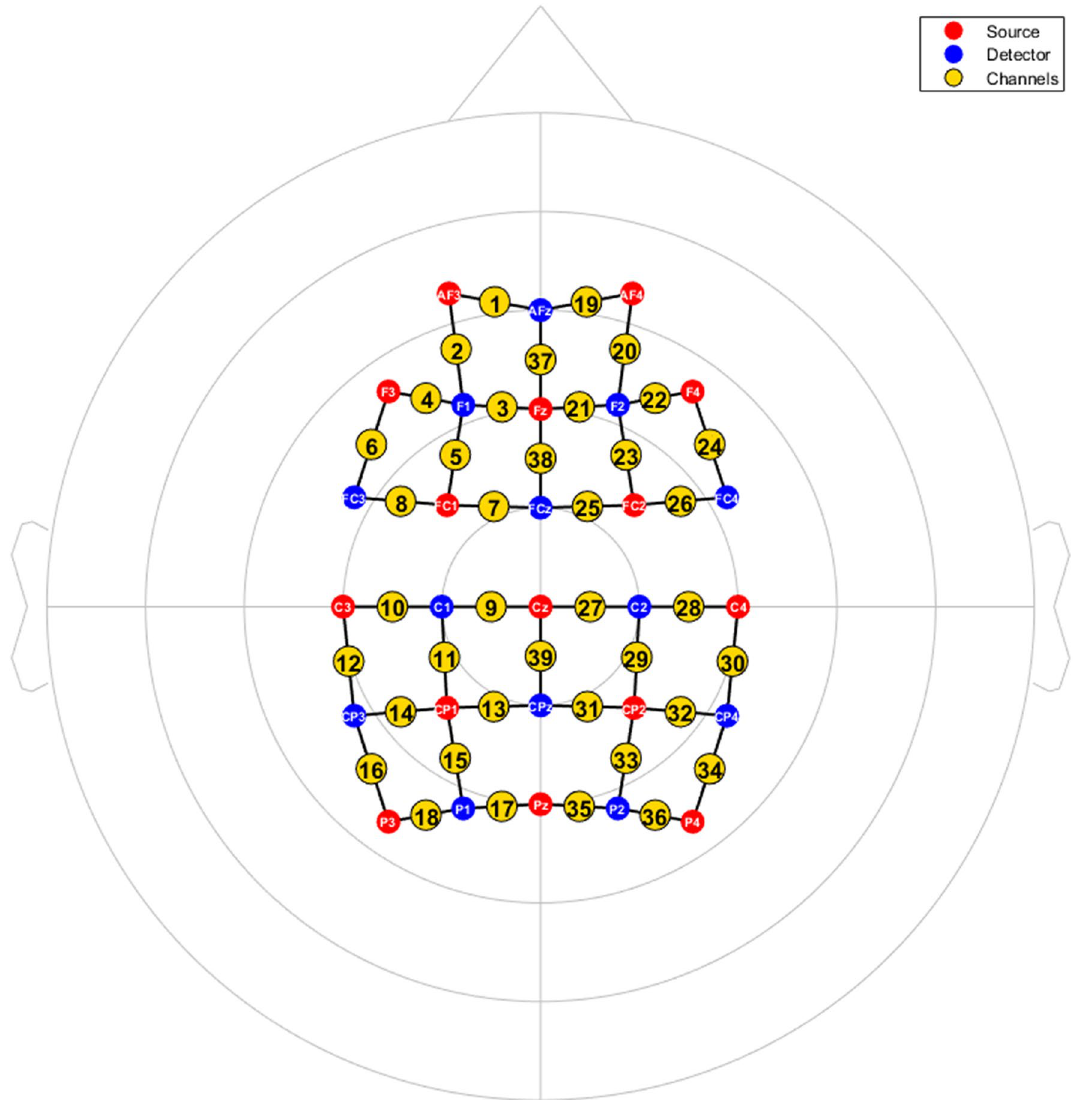
Figure 5. fNIRS recording montages for the experiment. Red circles indicate light sources, blue circles indicate detectors, and white letters designate the labels of the optodes, based on the 10–20 system. The yellow circles are the channels, which are numbered. The 2D coordinates of the optodes used in this figure were adopted from the NIRStar 14.1 program (NIRx Medical Technologies LLC, MN, USA, https:// nirx. net/ nirst